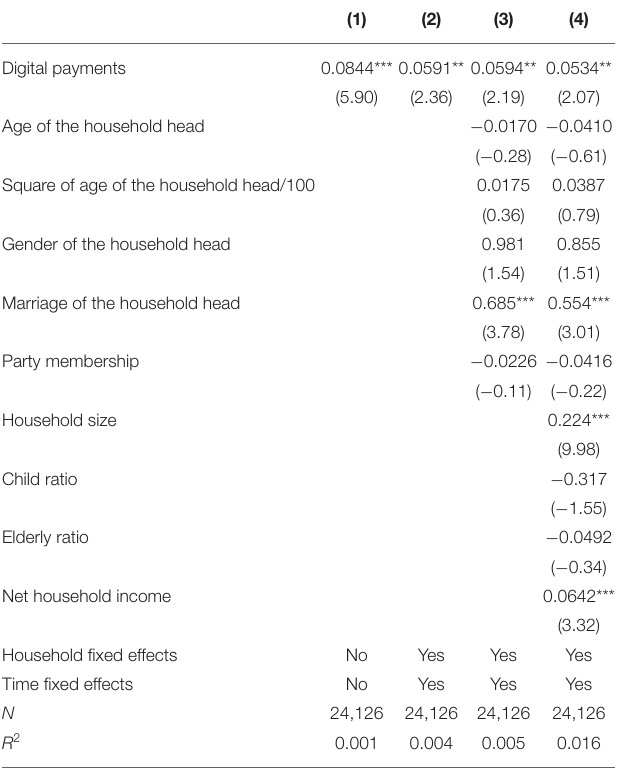
TABLE 2 | Baseline regression